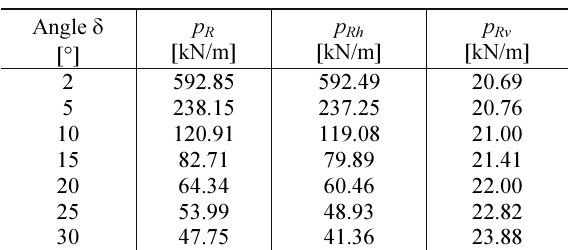
Table 2. Impacts produced by arching